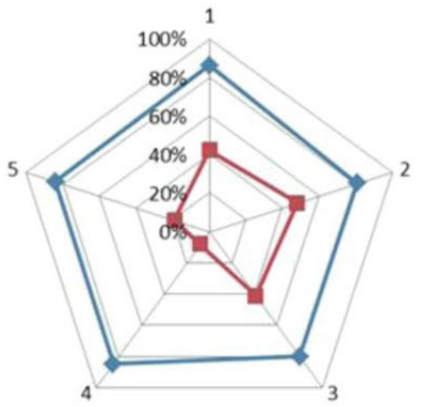
Figure 5. Dynamics of the formation of foreign language communicative competence